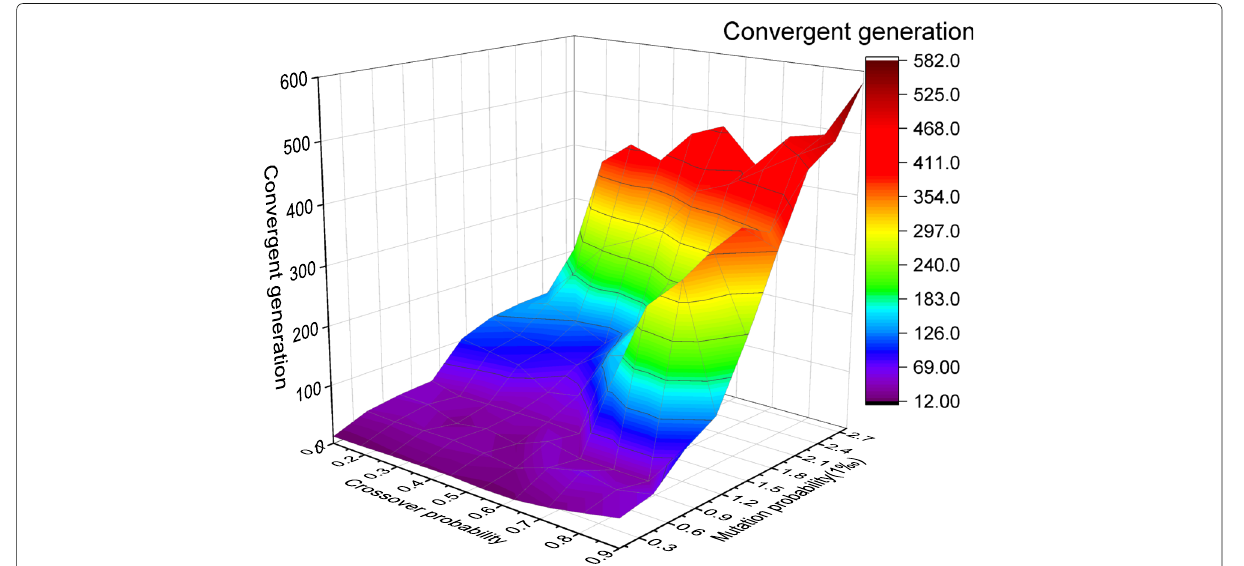
Fig. 12 Impact of C P and M P on convergent generation